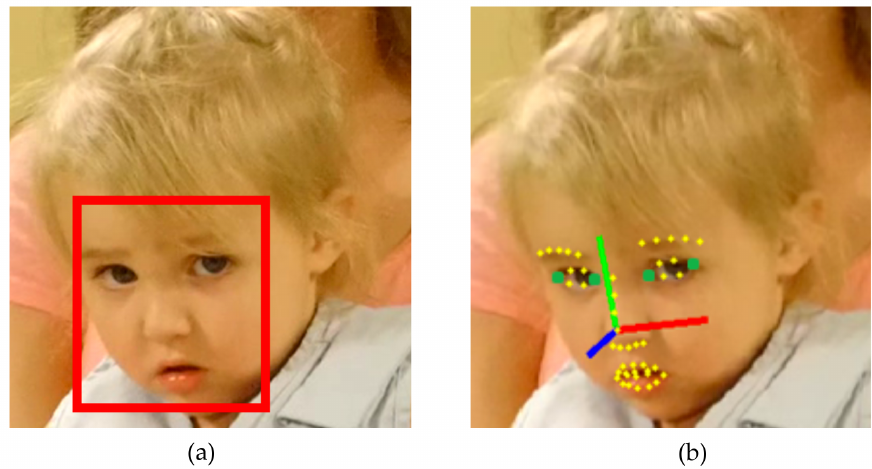
Figure 3. Perspective from the experimenter’s point-of-view eye tracking glasses. ( a ) Region of interest; ( b ) Head pose and eye direction overlays from a software application. ( c (cid:13) 2015 ACM. Reprinted with permission